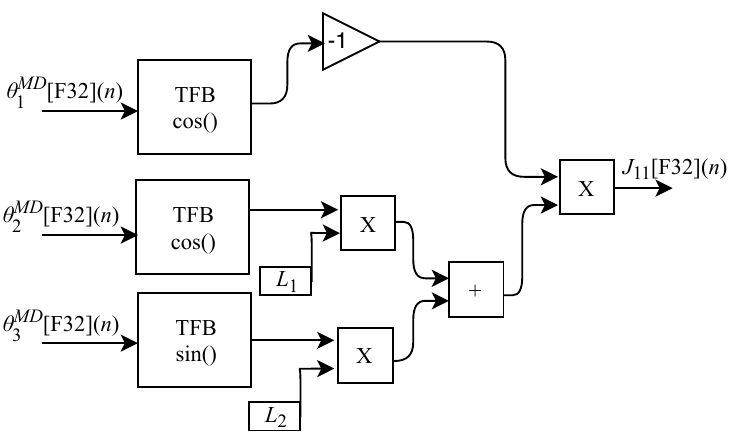
Figure 18. Proposed circuit to calculate the Jacobian matrix J 11 [ F 32 ]( n ) (Equation